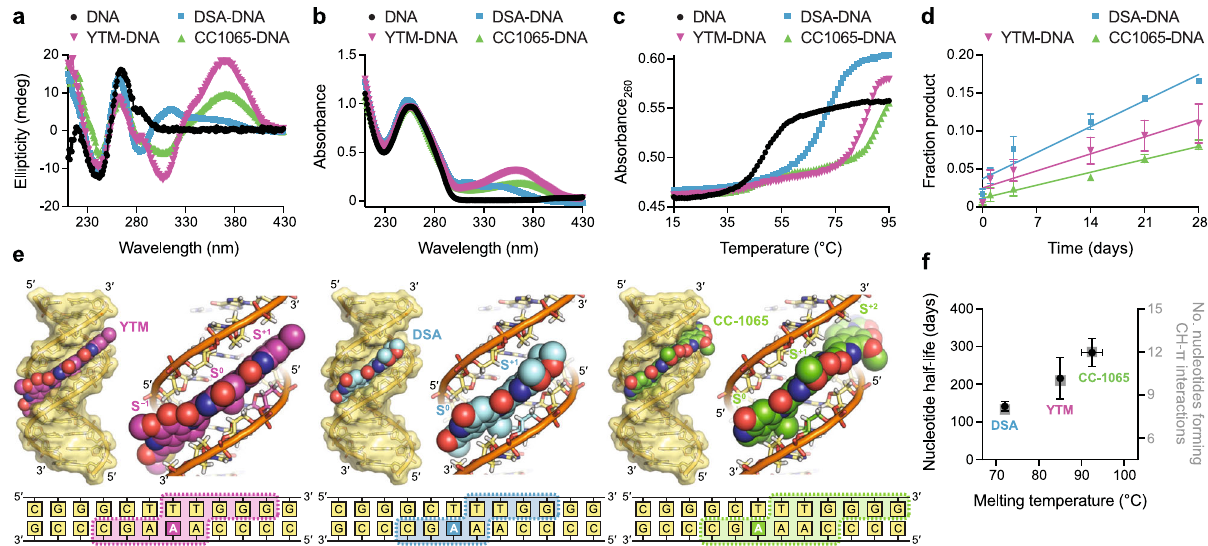
Fig. 2 Characterization of DNA adducts produced by YTM, DSA, and CC-1065. a , b Circular dichroism ( a ) and absorbance ( b ) spectra of unmodi fi ed and alkylated DNA collected at 15 °C. c Thermal melting pro fi les of unmodi fi ed and alkylated DNA. Melting temperatures ( T m,DNA = 49 °C, T m,DSA-DNA = 72 °C, T = 85 °C, and T ≥ 90 °C) were determined by fi tting the data to a polynomial function and calculating the in fl exion point of the m,YTM-DNA m,CC1065-DNA curve. Spectra and melting pro fi les for unmodi fi ed DNA and YTM-DNA were previously described by Mullins et al. 18 . d Spontaneous depurination of alkylated DNA at 30 °C. The data were fi t to a linear model and half-lives ( t 1/2,DSA-DNA = 142 ± 11 days, t 1/2,YTM-DNA = 224 ± 56 days, and t 1/2,CC1065- = 288 ± 36 days) were calculated assuming fi rst-order kinetics. Data are presented as the mean ± SD from three replicate experiments. e Hypothetical DNA models of DNA modi fi ed by YTM, DSA, and CC-1065. The dashed boxes indicate nucleotides that are predicted to form CH- π interactions with the SCPCHD adducts. f Correlation between melting temperature, rate of spontaneous depurination (plotted as nucleotide half-life), and number of nucleotides forming CH- π interactions, derived from c , d , and e , respectively. Horizontal error bars represent uncertainty in the melting temperature of CC1065-DNA caused by the lack of an endpoint in the melting pro fi le. As such, the estimated melting temperature of CC1065-DNA was plotted as the average value ± the range of values calculated assuming endpoints between those of unmodi fi ed DNA (minimum) and DSA-DNA (maximum). Nucleotide half-lives are presented as the mean ± SD from three replicate experiments. Source data for a – d and f are provided as a Source Data fi